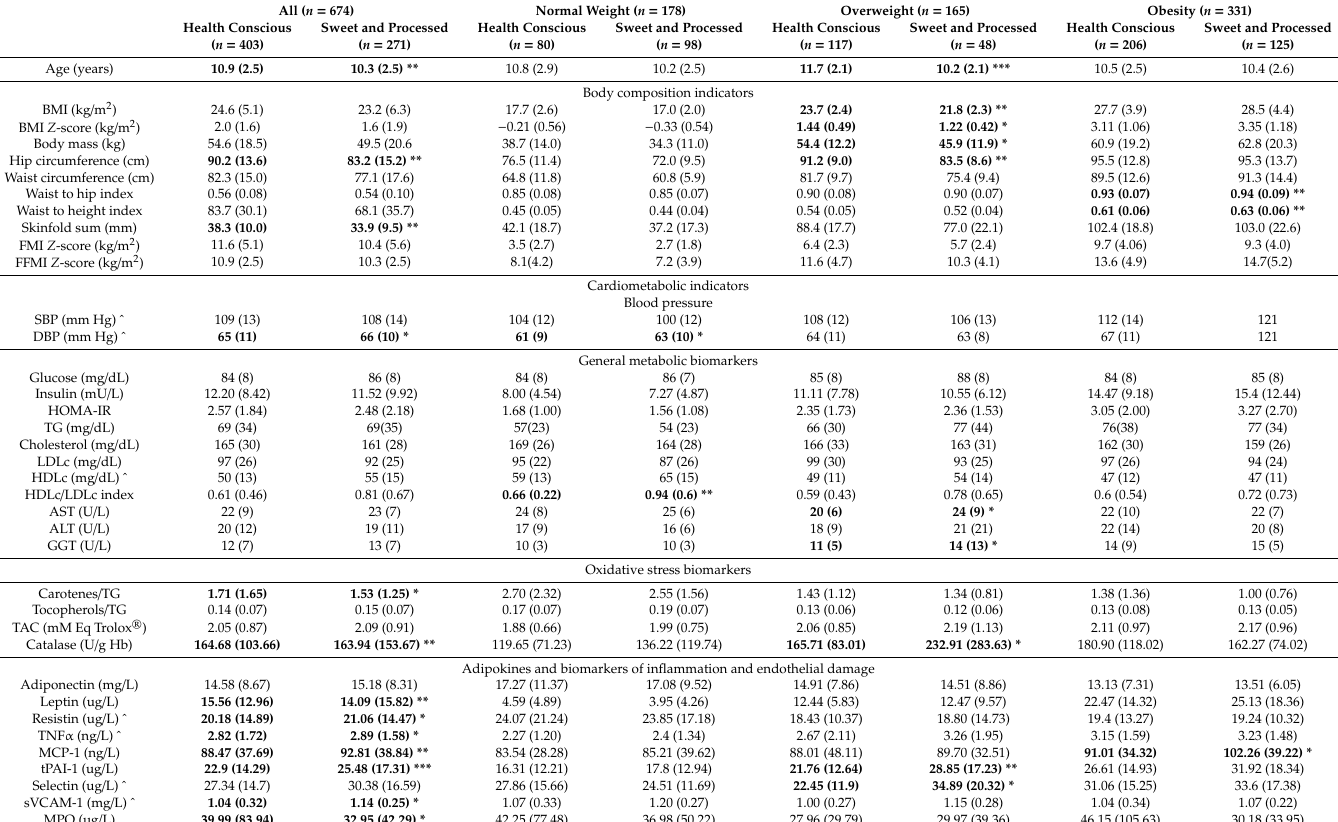
Table 3. Mean di ff erences of cardiometabolic and health risk indicators between dietary clusters in the three BMI subgroups of children and adolescents (GENOBOX